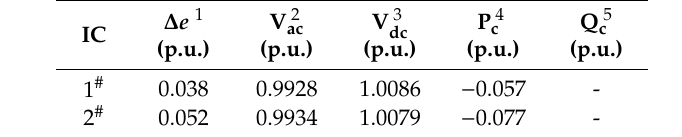
Table 8. Test results of the transferred power by interfacing converters (ICs) in the 12-bus IHMG